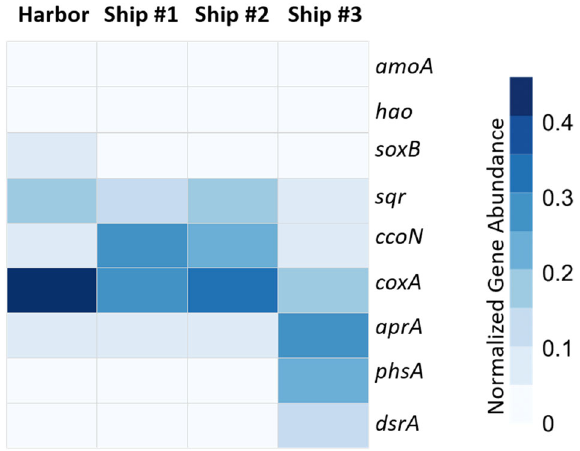
Fig. 2 Metagenome analysis of selected energy conservation genes. Gene abundances are normalized to single-copy marker gene ( rpoB ) abundance for each sample. Colors are scaled based on values in discrete rows. Gene abbreviations: amoA , ammonia monooxygenase; hao , hydroxylamine oxidoreductase; soxB , sulfur oxidation gene; sqr , sul fi de:quinone oxidoreductase; ccoN cbb3-type cytochrome C oxidase; coxA , aa3-type cytochrome C oxidase; aprA , adenylylsulfate reductase; phsA , thiosulfate reductase; dsrA , dissim- ilatory sul fi te reductase.